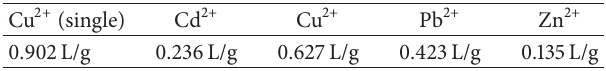
Table 4: Distribution coefficient for single Cu 2+ ions and Cd 2+ , Cu 2+ , Pb 2+ , and Zn 2+ ions adsorbed from their mixture.